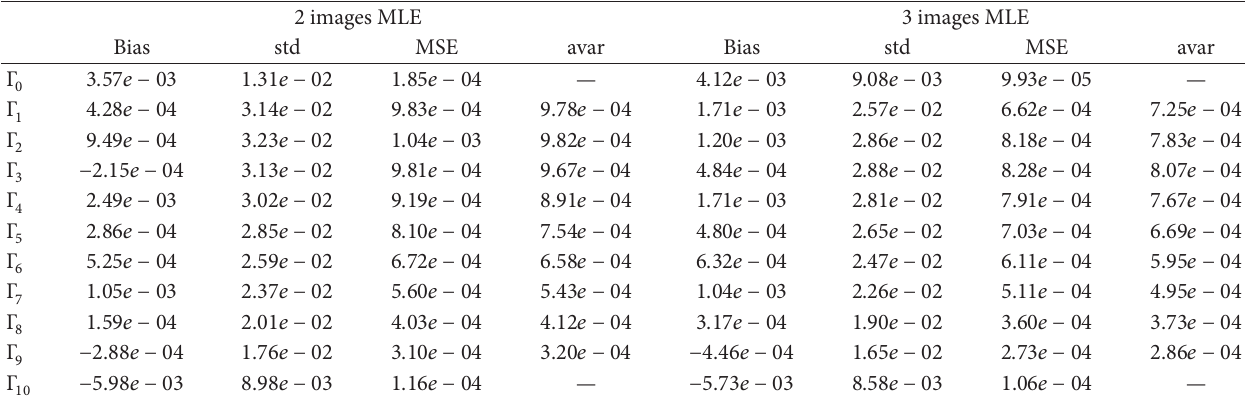
Table 2: Simulation results for the estimation of 𝑃 2 using 2 or 3 images, obtained from 1000 Monte-Carlo runs ( 𝑛 = 51 × 51 ). 2 images MLE 3 images MLE